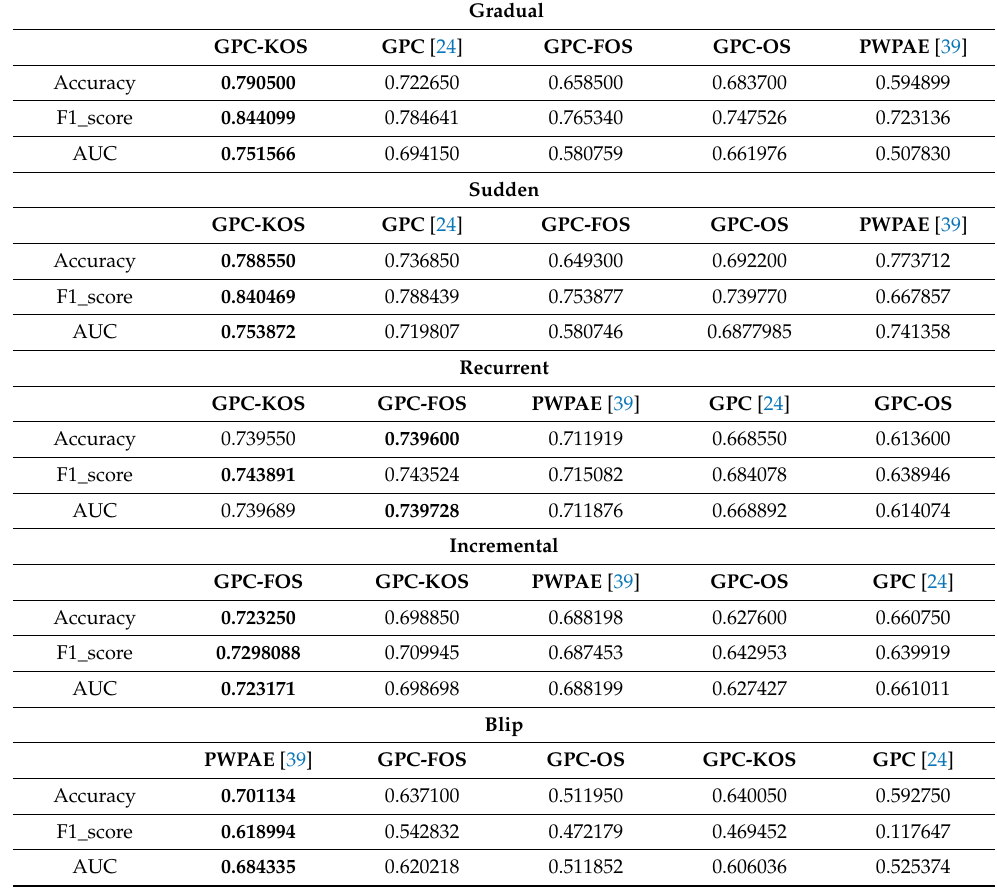
Table 6. Summary of numerical values of accuracy, F1-score, and AUC for GPC variants (OS, FOS, KOS) and benchmarks in synthetic